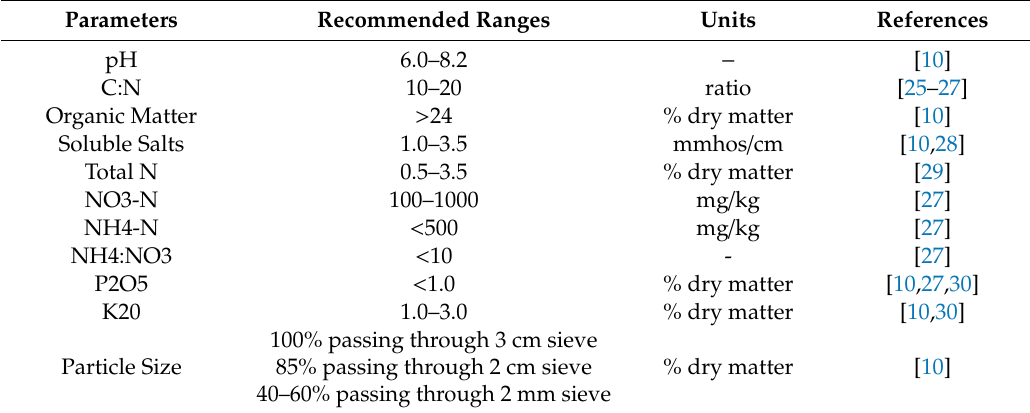
Table 5. Recommended ranges of compost characteristics for urban soil remediation. Recommended ranges were based on results found in the author’s experiment, confirmed and supplemented by the literature.